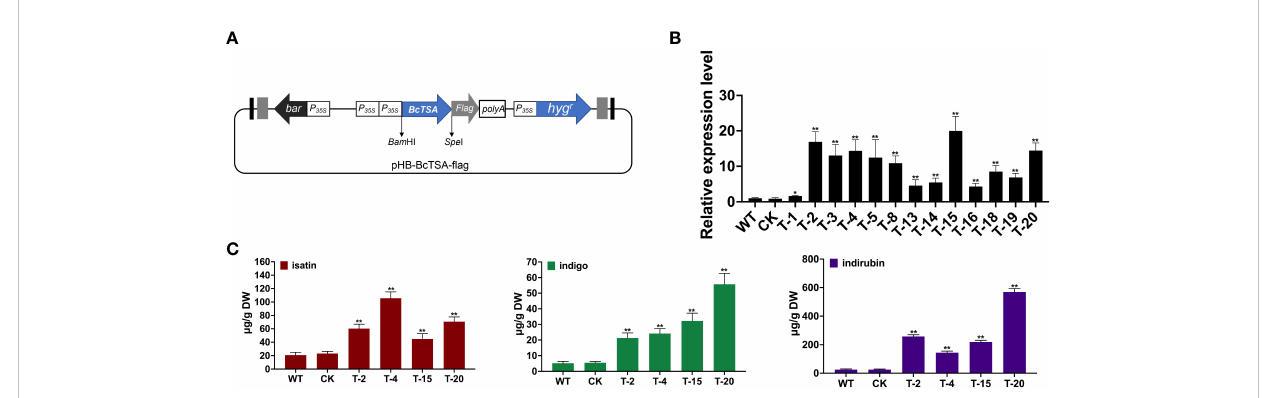
FIGURE 6 Hairy root cultures of BcTSA-overexpressed in l. indigotica . (A) Schematic representation of the overexpression vector used for hairy root establishment. (B) BcTSA transcript abundance in hairy root cultures by RT-qPCR. (C) LC-MS/MS analysis of isatin, indole, and indirubin of different I. indigotica hairy root including the BcTSA overexpression lines, transformed with the empty vector, and the WT control. Each data point is the average of three biological replicates. Data are represented as the mean ± SEM; * P < 0.05 and, ** P < 0.01 compared to the WT